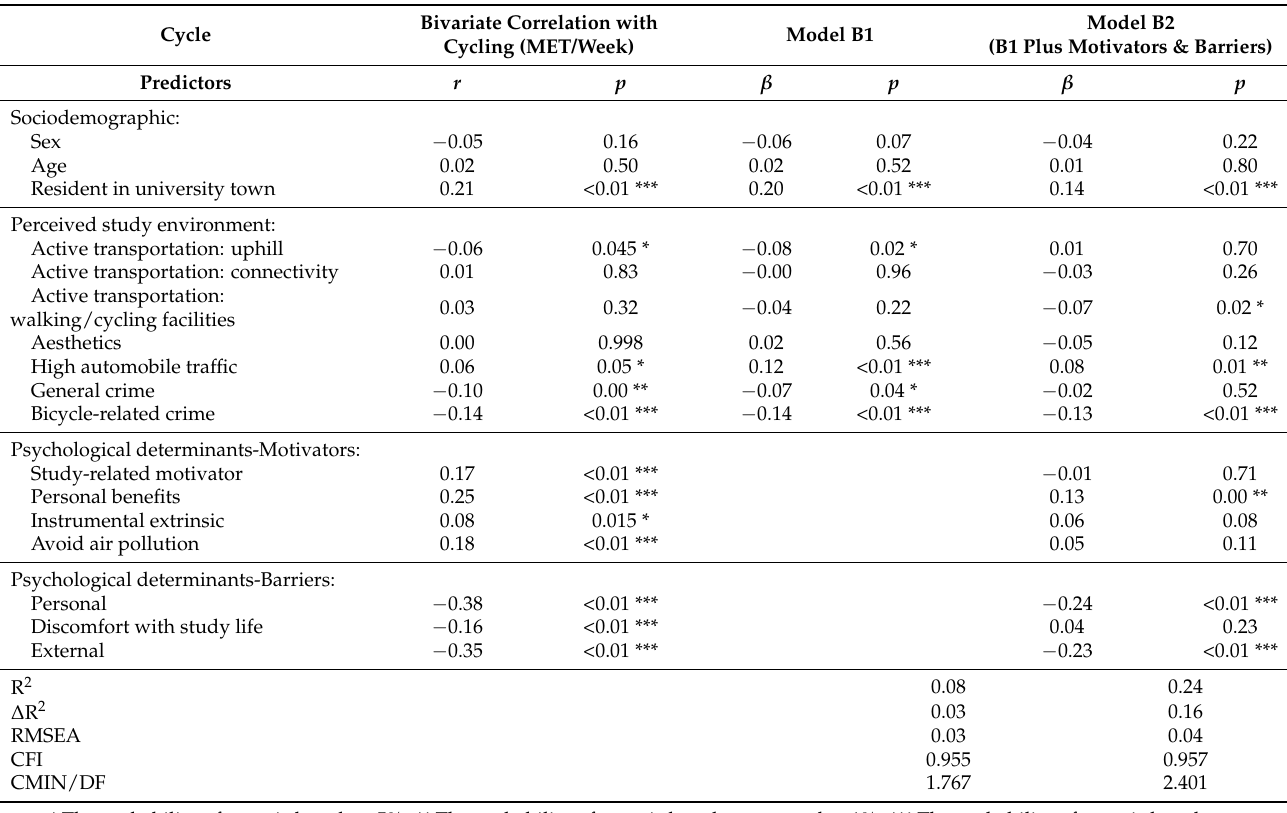
Table A8. Results (inter-item-correlation-coefficients r, β -coefficients and significant p -value) for the bivariate correlation and multivariate regression models B1 (sociodemographics and perceived study environment) and B2 (B1 plus Motivators & Barriers) for the transportation mode